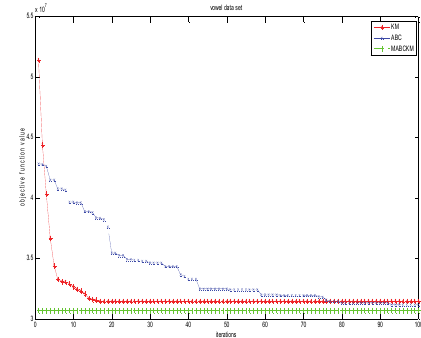
Fig. 3. Comparison of OFV on lung cancer data set Fig. 4. Comparison of OFV on soyabean (small) data set